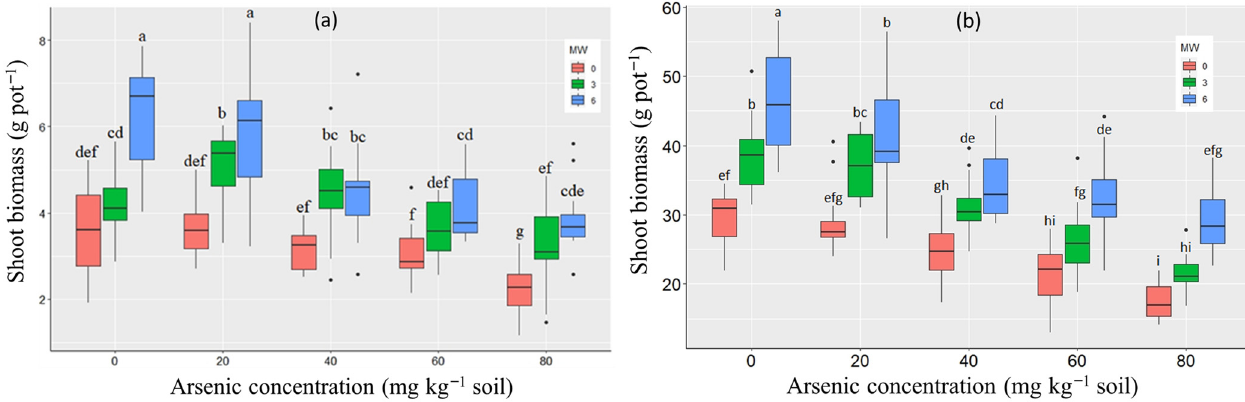
Figure 3. Mean shoot biomass yield at ( a ) tillering stage and ( b ) physiological maturity stage in response to arsenic (As) and microwave (MW) soil treatments. In boxplot, values having different letter indicates the significant difference (LSD test at 5% level of significance) among the treatments.